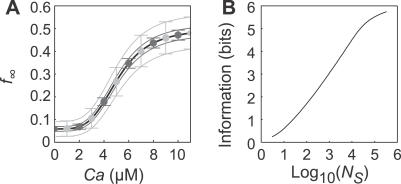
Information Coding(A) The steady-state phosphorylated fraction, f
∞, is a graded function of Ca in the deterministic (thick black line) and stochastic models (circles; number of substrate molecules, NS, is 500 [dark gray] and 50 [light gray]). Standard deviations were derived from simulations (error bars) or theoretical probability distributions (gray lines; see Methods, Equations 16–17).(B) The information about Ca encoded in f versus NS.